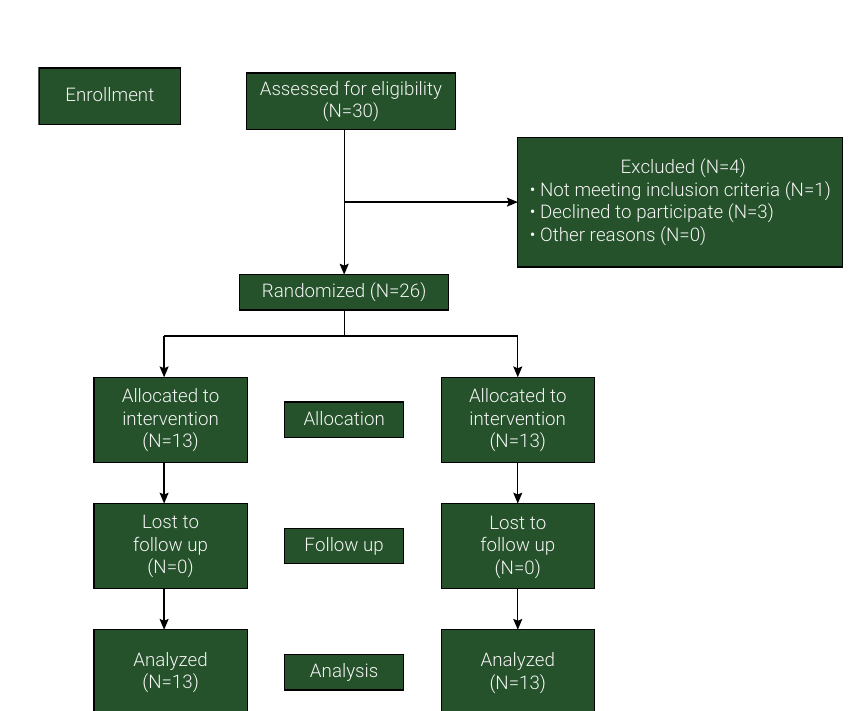
Figure 1. Consort flow diagram of the